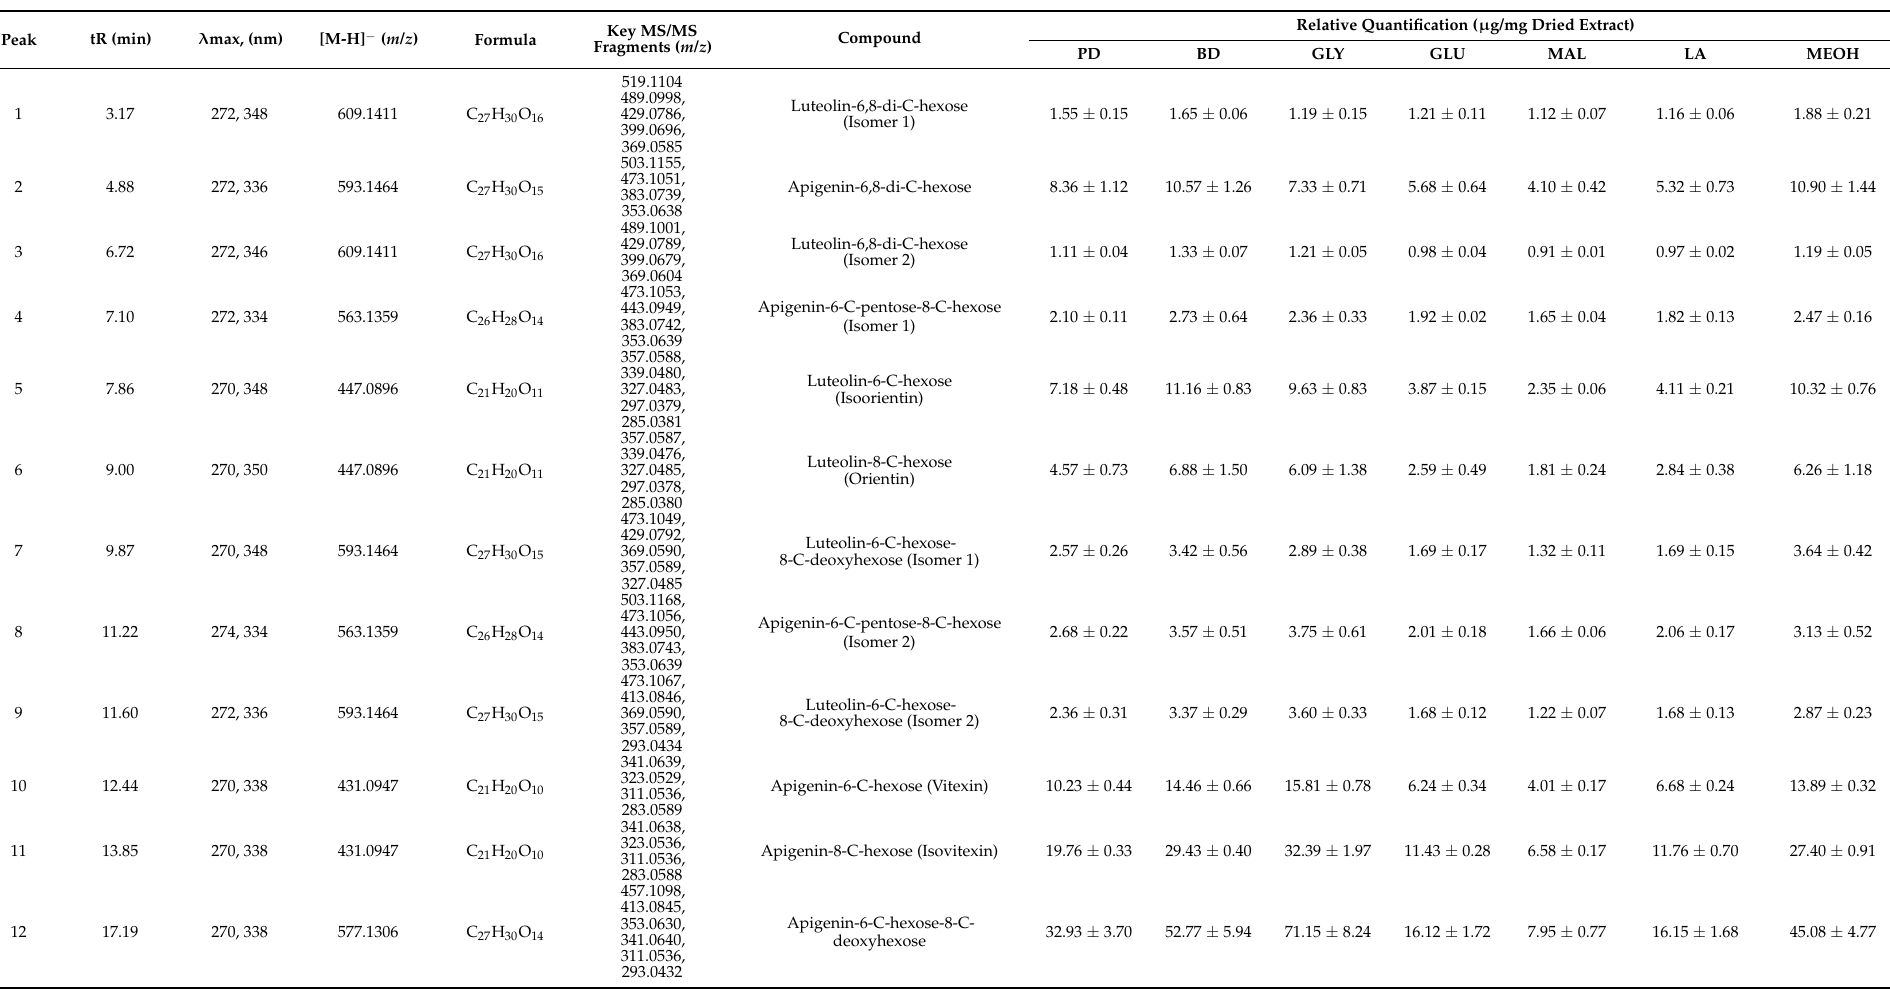
Values are presented as mean ± standard deviation of three measurements. Peak assigned to luteolin or apigenin derivatives was quantified relatively in orientin or vitexin equivalents ( µ g/mg dried extract), respectively. PD, choline chloride-1,2 propanediol; BD, choline chloride-1,4 butanediol; GLY, choline chloride-glycerol; GLU, choline chloride-glucose; MAL, choline chloride-maltose; LA, choline chloride-lactic acid; MEOH, aqueous